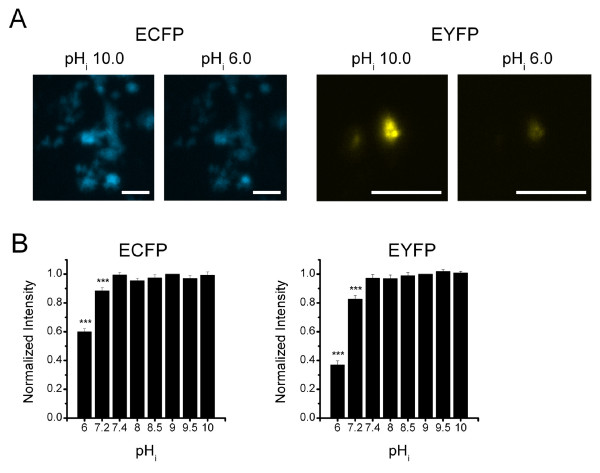
Effect of the pHi on the fluorescence intensities of ECFP or EYFP fused to the Kir2.1 channel. A. Images of HEK293T cell plasma membrane sheets expressing ECFP-Kir2.1 or Kir2.1-EYFP exposed to pHi 10.0 or 6.0. For clarity of presentation (but not during data analysis), the contrast of photos was increased by 20% with Photoshop CS3. B. Averaged effect of the pHi on the florescence intensities of ECFP-Kir2.1 or Kir2.1-EYFP in plasma sheets (C, n = 15). The fluorescence intensities were normalized to those obtained at pHi 10.0. *** indicates p < 0.005 compared to the pHi 10.0 value.